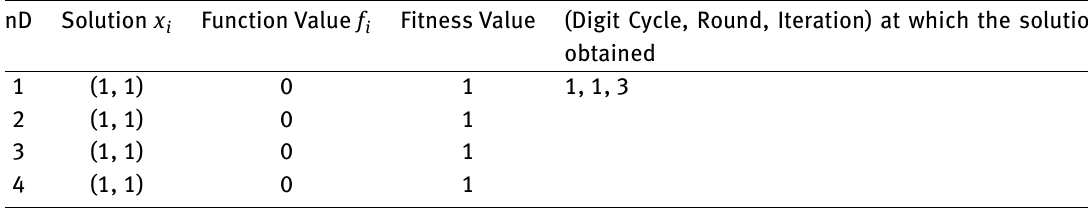
Table 14: Digit Cycle Results for Rosenbrock’s function with 2 variables nD Solution x i